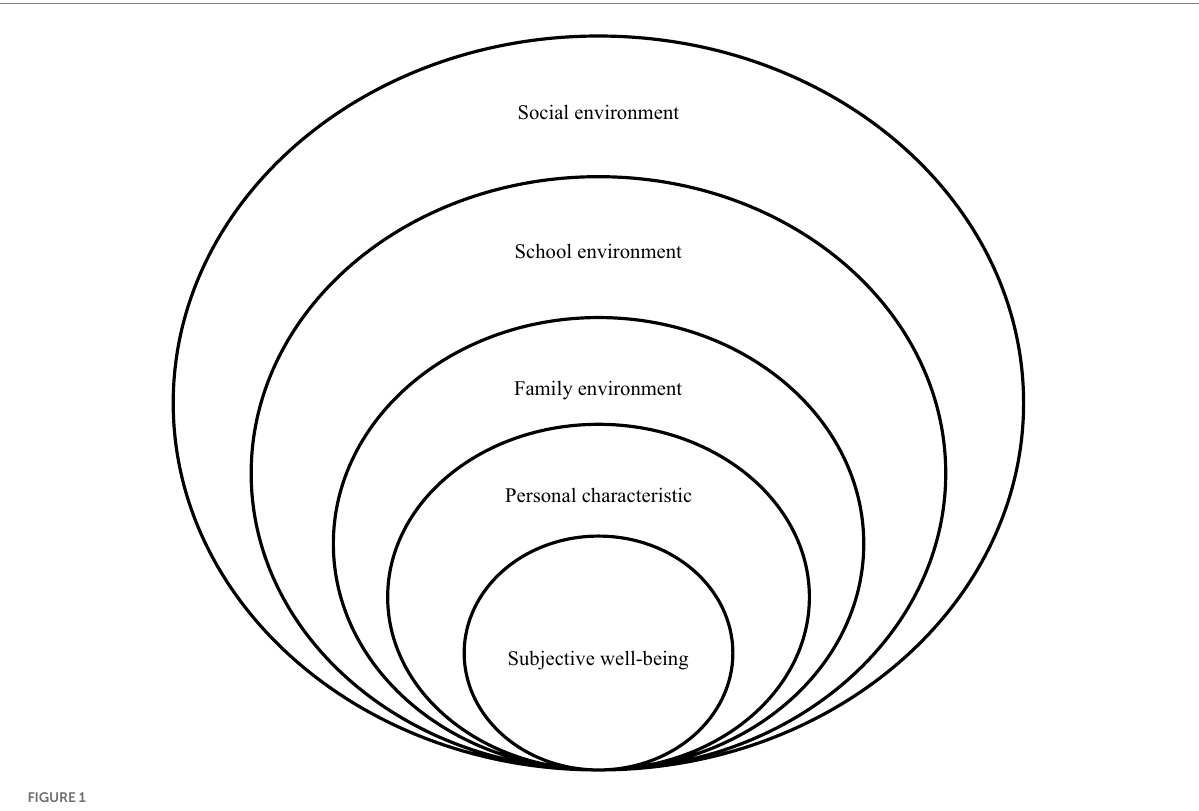
FIGURE 1 Influencing factors of adolescents’ subjective